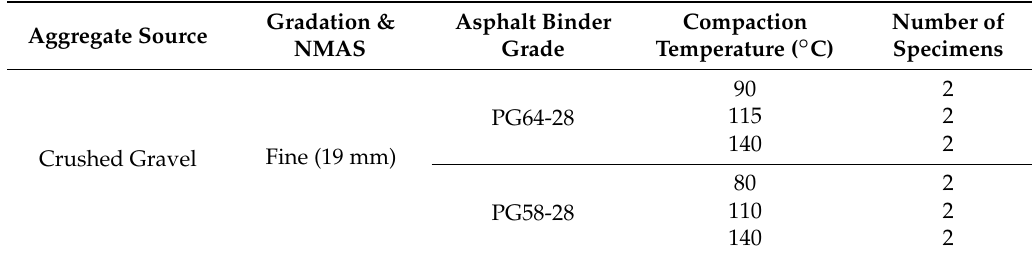
Table 1. Compaction matrix. (NMAS: Nominal maximum aggregate